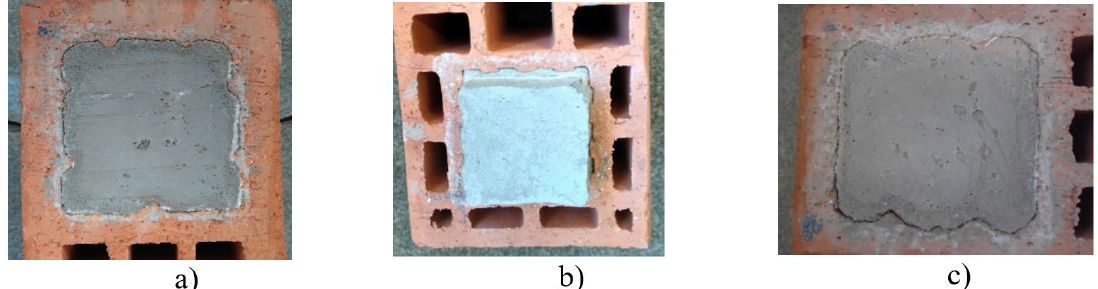
Figure 6. Signs of shrinkage of the grout.